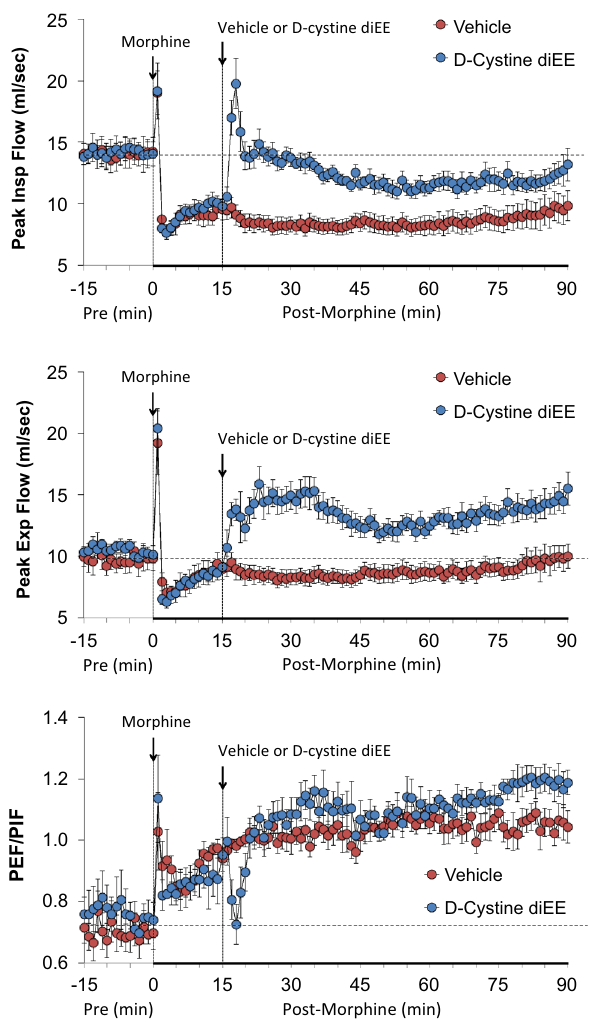
Figure 3. Changes in peak inspiratory flow (top panel), peak expiratory flow (middle panel) and peak expiratory flow/peak inspiratory flow (PEF/PIF) (bottom panel) in freely moving rats upon (a) injection of morphine (10 mg/kg, IV) and subsequent injection of vehicle (saline) or d-cystine diethyl ester (d-cystine diEE, 500 μmol/kg, IV). The data are presented as mean ± SEM. There were 9 rats in each